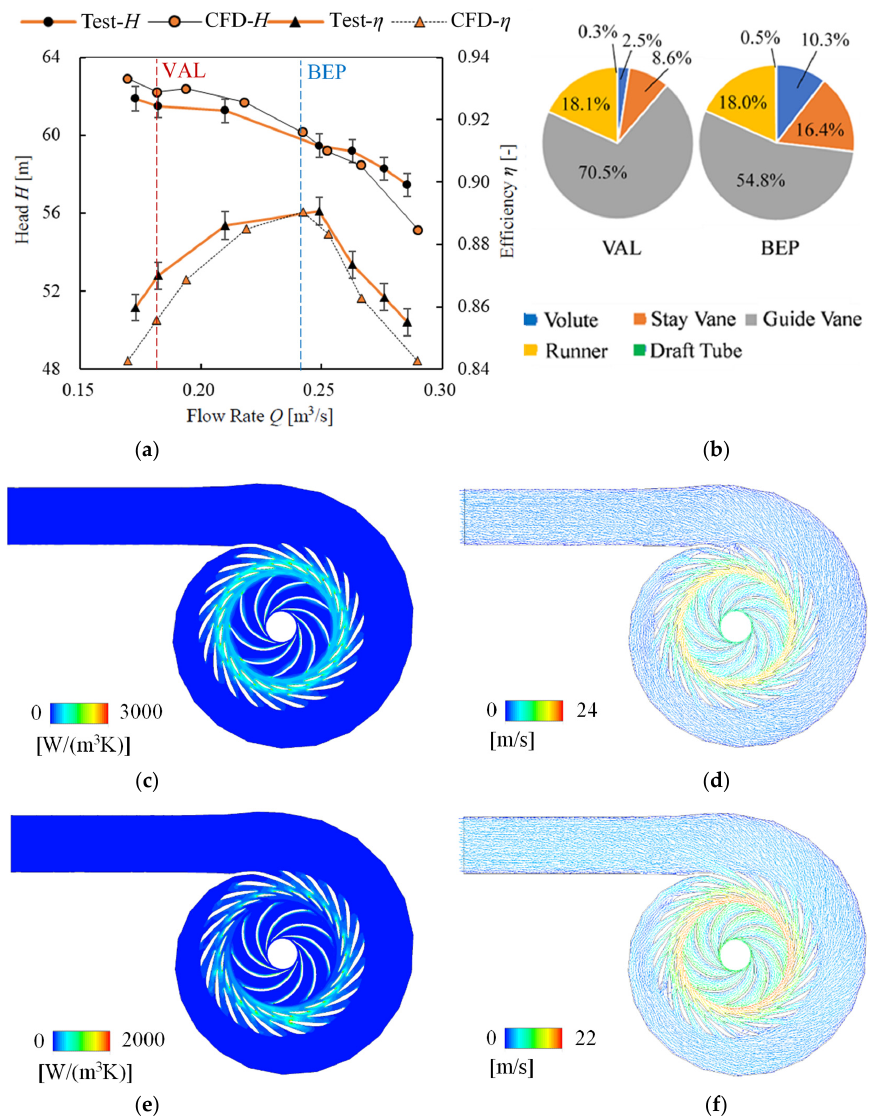
Figure 10. Performance curve and flow pattern at 10° attack angle. ( a ) Q-H and Q- η curve; ( b ) proportion of flow energy loss; ( c ) VAL S pro ; ( d ) VAL v ; ( e ) BEP S pro ; ( f ) BEP v ; VAL: local valley of Q-H curve; BEP: best efficiency point.